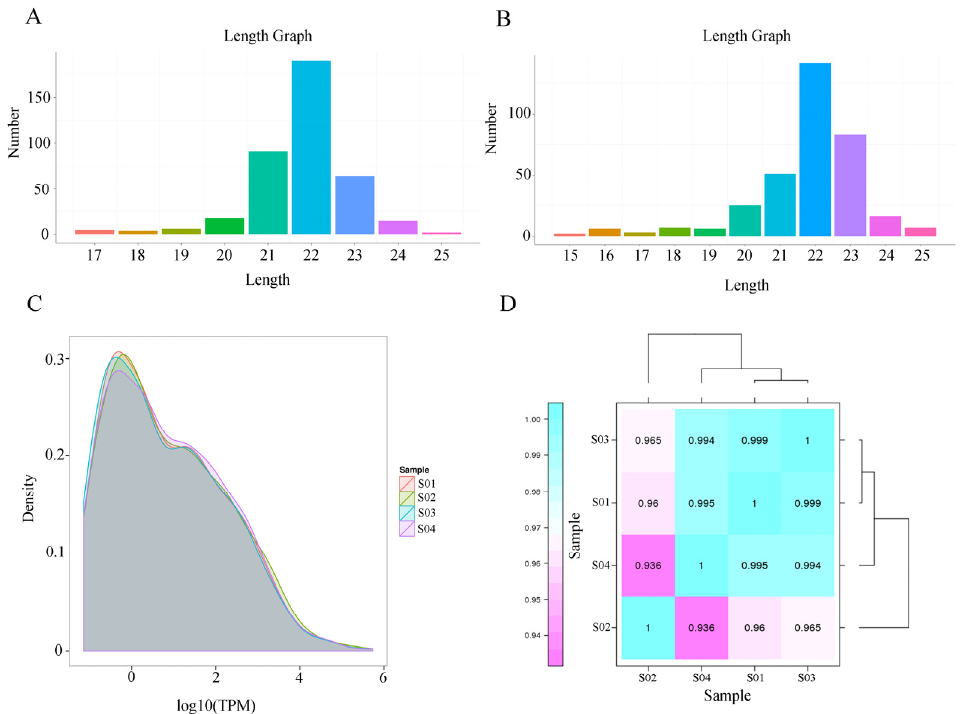
Figure 3. Results of miRNA sequencing in the adenohypophysis of rats after GnRH treatment. ( A , B ) Statistical analysis of miRNA length. ( C ) Overall distribution of miRNA expression. The curves of different colors in the figure represent different samples, the horizontal coordinates of the points on the curves indicate the logarithmic values of the TPM of the corresponding samples, and the vertical coordinates of the points indicate the probability density. ( D ) Sample correlation relationship chart. Different colors in the graph represent different correlation coefficient values. The horizontal and vertical coordinates represent different samples.